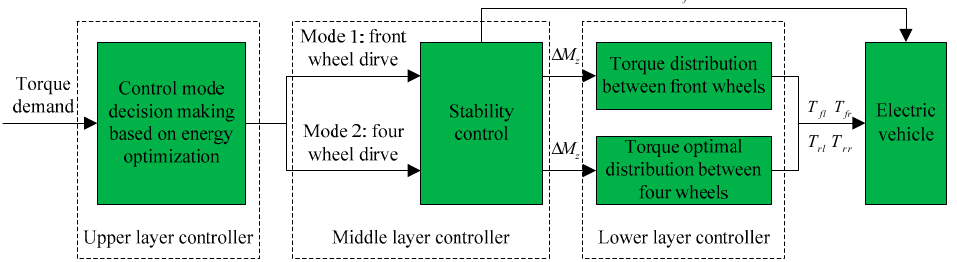
Figure 5. Overall control strategy.